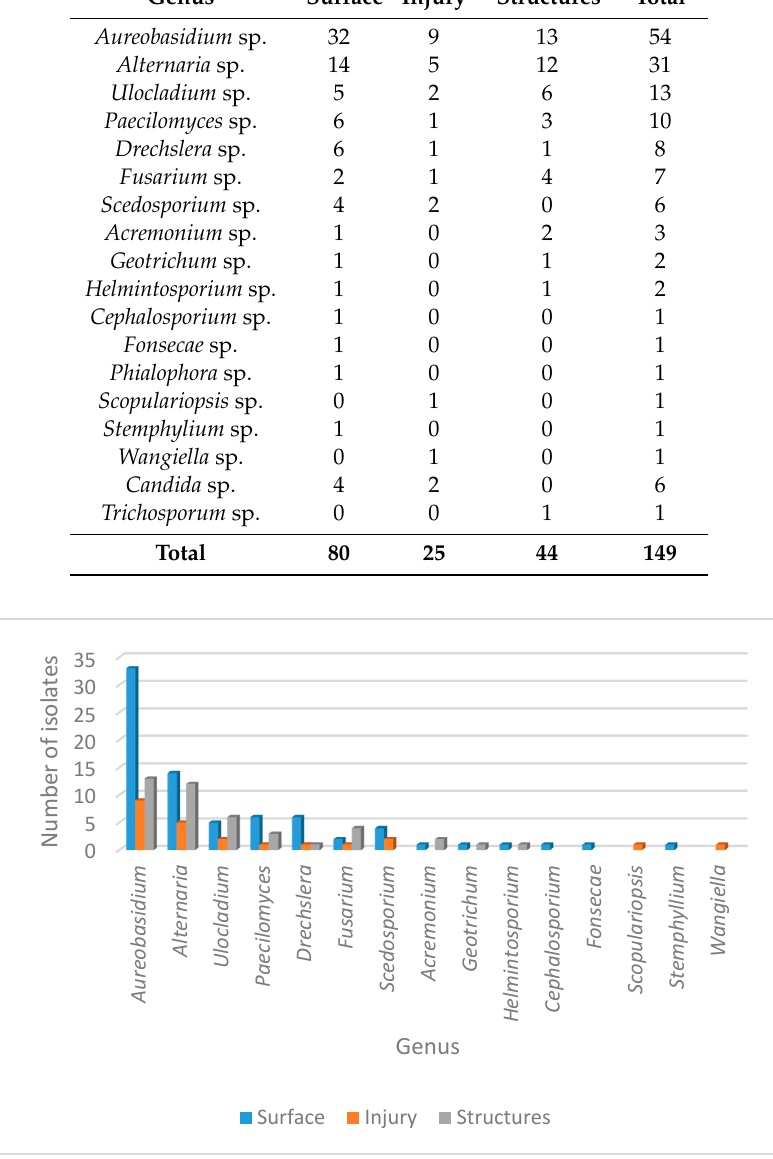
Table 1. Frequency of isolation for the genera identified according to their origin. Genus Surface Injury Structures Total Ulocladium sp. Aureobasidium sp. 32 54 Alternaria sp. 14